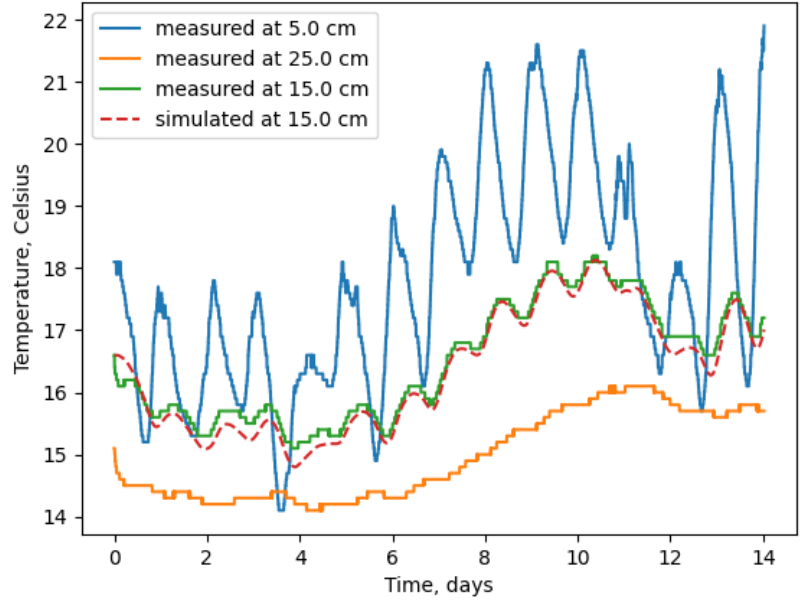
Figure 2. Moss temperature series measured at top (5 cm), bottom (25 cm) and middle (15 cm), of the test moss layer, and simulated in the middle of the layer at the optimal value of the temperature diffusivity coefficient a 0